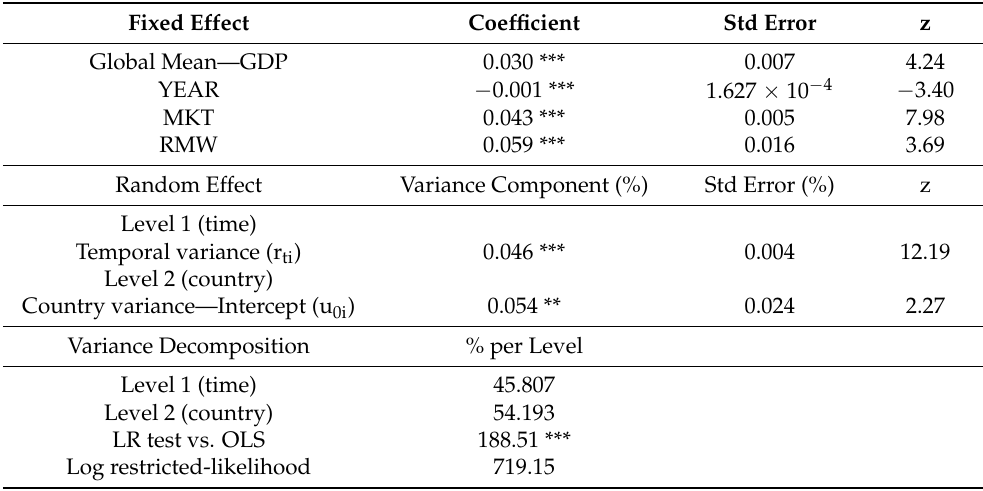
Table 9. Decomposition of variance—Linear Trend Model with Random Intercepts and MKT and RMW Explanatory Variables, Which Captures the Level 2 Random Effects—Final Complete Model.